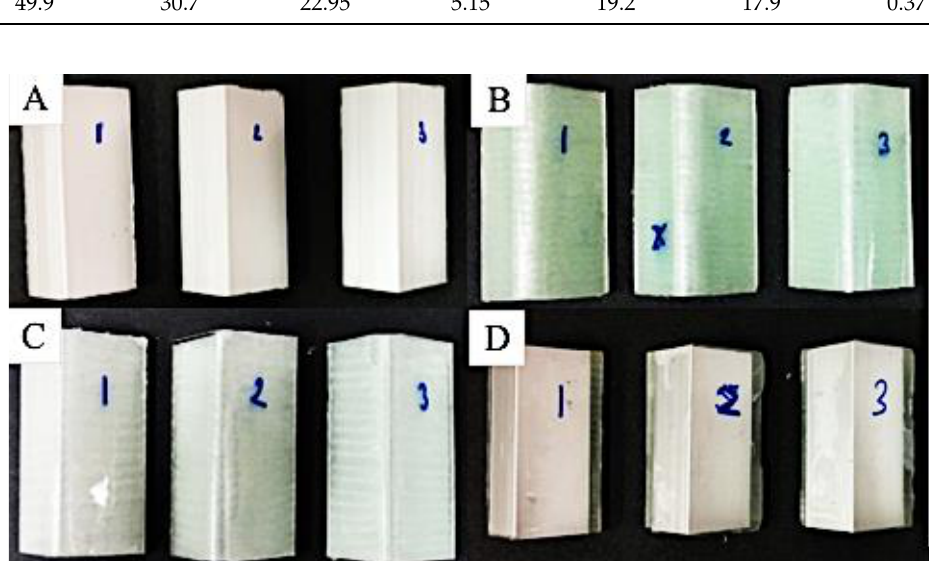
Figure 6. Axial compression test specimens. ( A ) Aluminium L-Profile; ( B ) GFRP Profile; ( C ) Hybrid laminates with GFRP attached on the outer surface of L-Profile; ( D ) Hybrid laminates with GFRP attached on the inner surface of L-Profile.